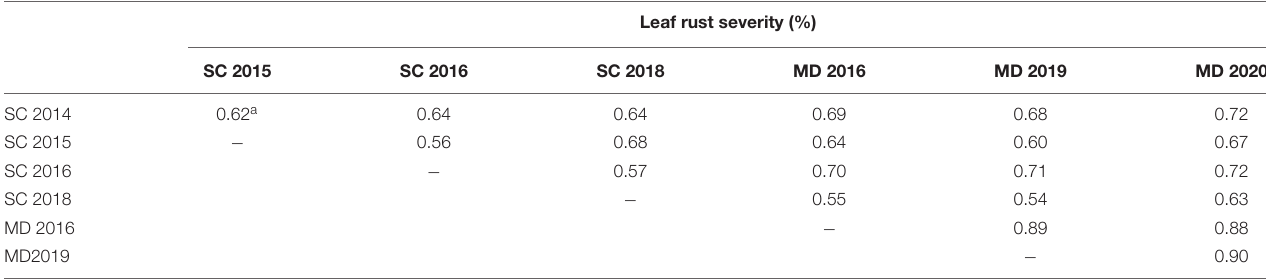
TABLE 4 | Pearson correlation coefficients (r) of the relation between leaf rust severities of the DH lines of the Carberry/Thatcher population evaluated near Morden (MD) and Swift Current (SC) from 2014 to 2020.